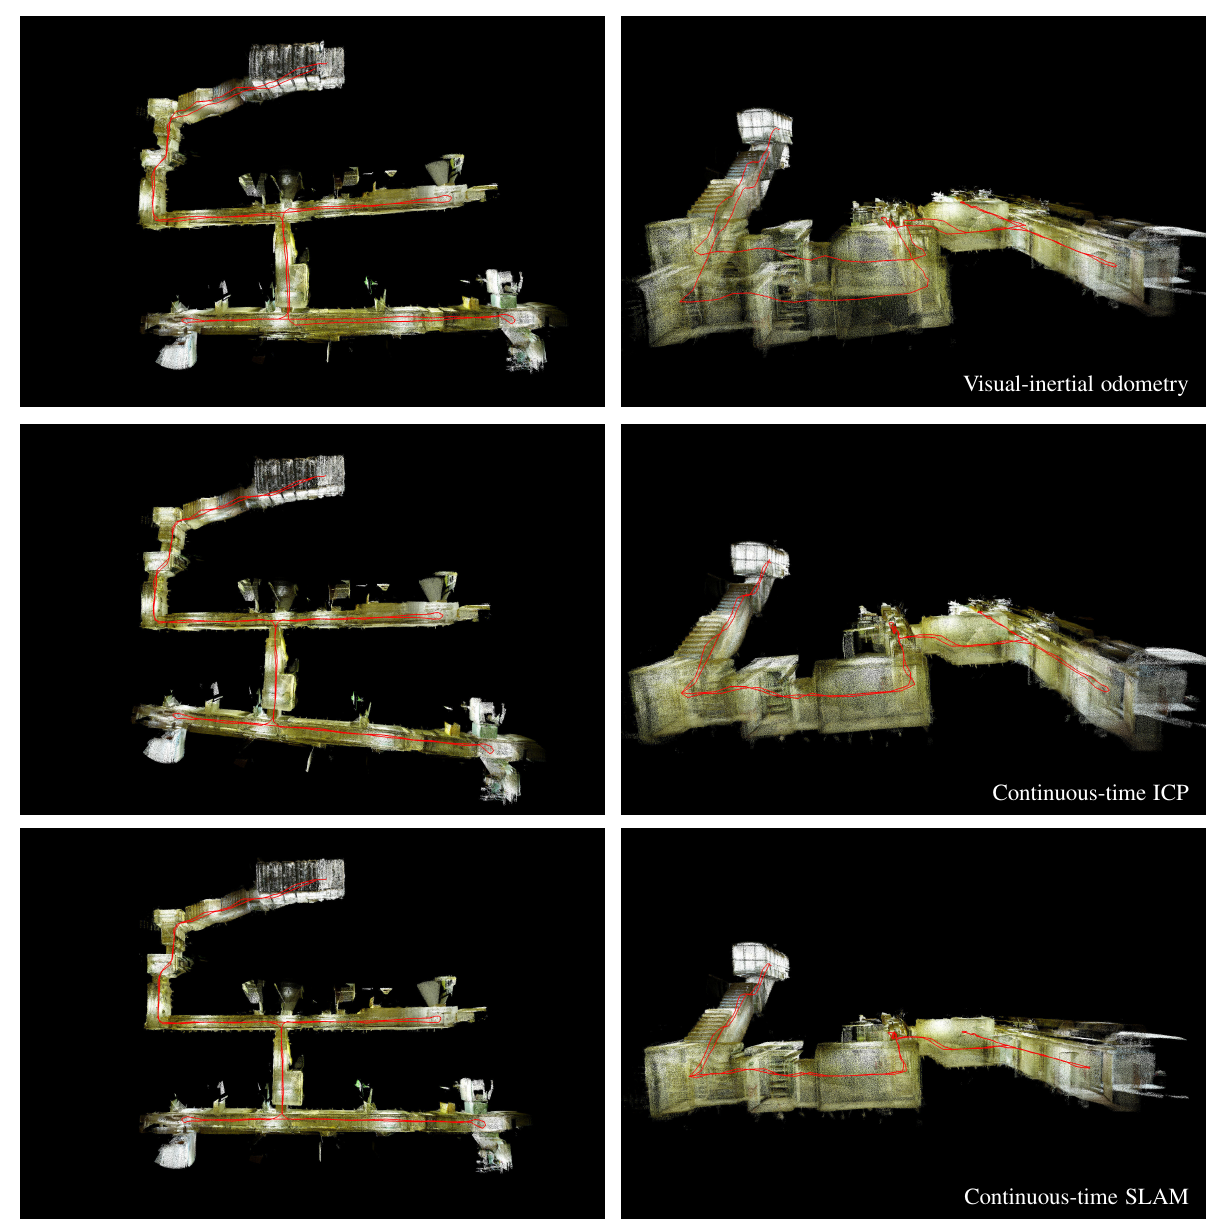
Figure 6. Point cloud result after the different trajectory optimization steps. The trajectory of the backpack is overlayed in red color. Top row: Visual-inertial odometry result. Middle row: Result after continuous-time ICP registration. Bottom row: Final result created using continuous-time